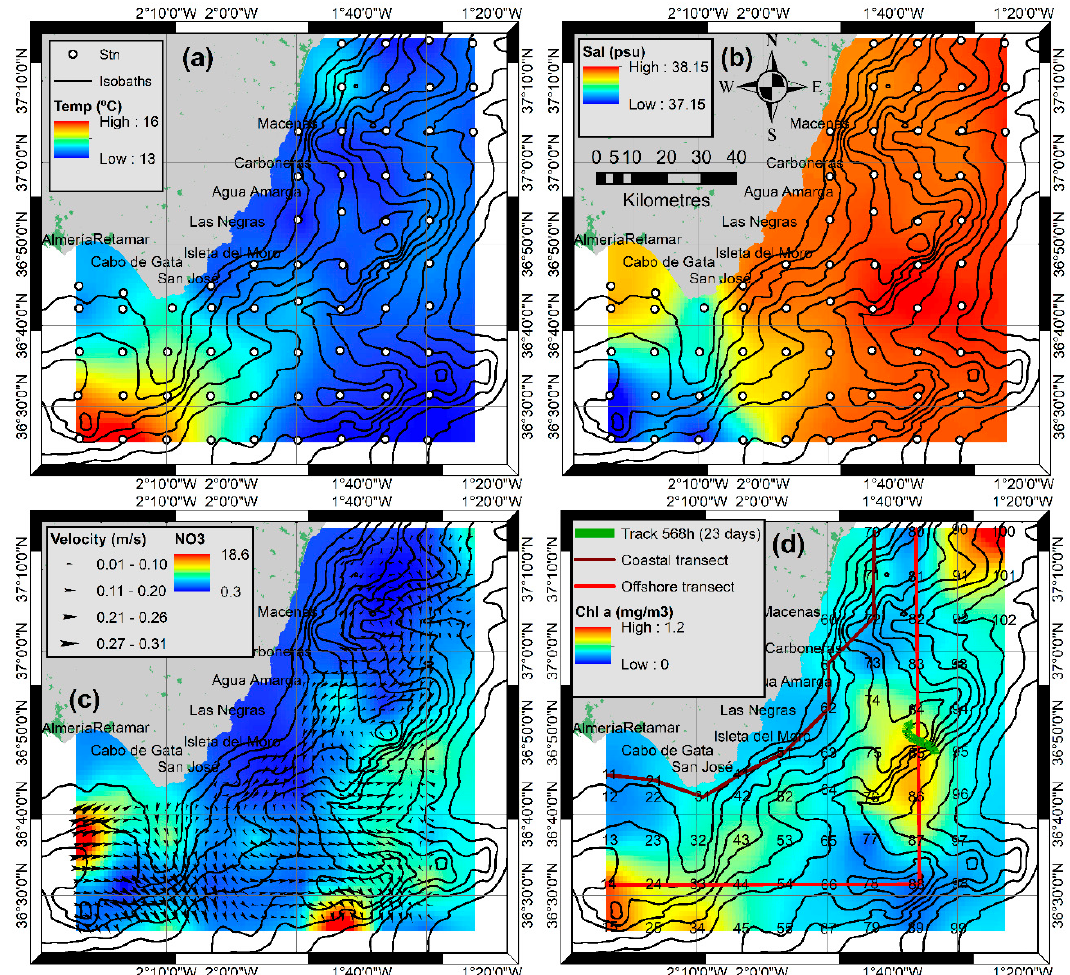
Figure 4. Spatial patterns at 75-m depth of ( a ) temperature ( ◦ C), ( b ) salinity, ( c ) nitrate concentration ( µ M) and horizontal currents (m · s − 1 ), and ( d ) chlorophyll a (mg · m − 3 ) concentrations and horizontal particle track from longitude 1.616 W and latitude 36.851 N (Stn 65) at 75-m depth. Red and dark ‐ red lines in Figure 4d indicate the offshore and coastal transect shown in Figures 5 and 6, respectively.